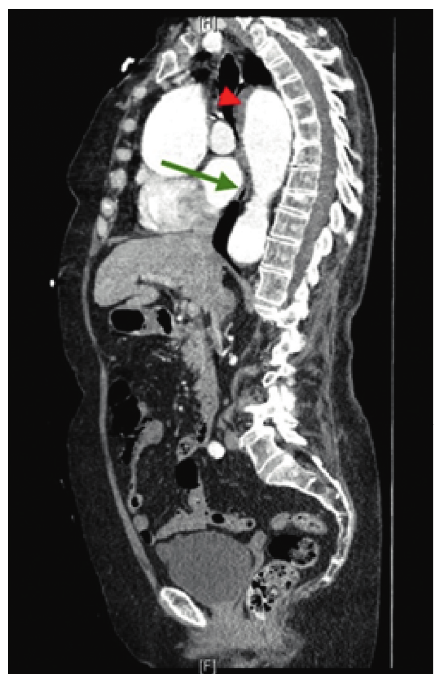
Figure 1: Sagittal section of CT angiogram of the chest showing thoracic aorta aneurysm of approx. 5.5cm size causing extrinsic compression at midesophageal level (green arrow) along with intramural thrombus in the thoracic aorta (red